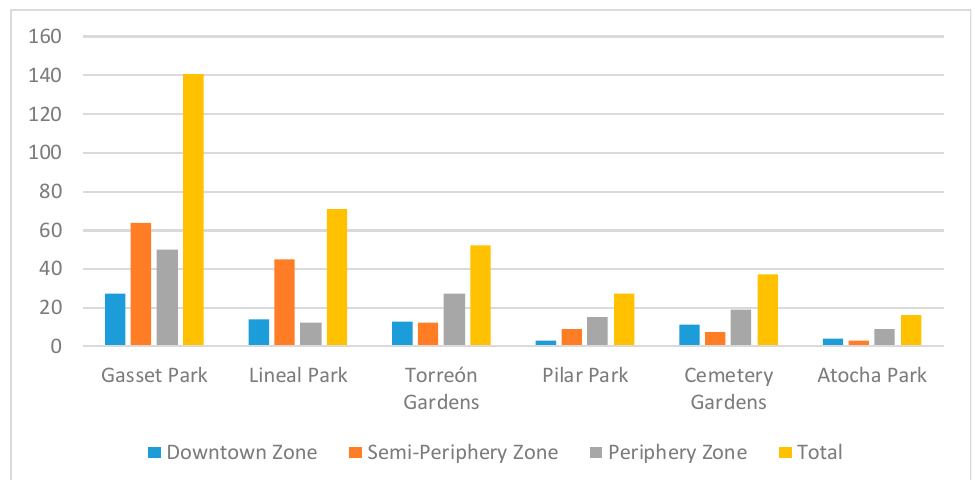
Figure 5. Results of answers related to natural heritage. Source: Own work.